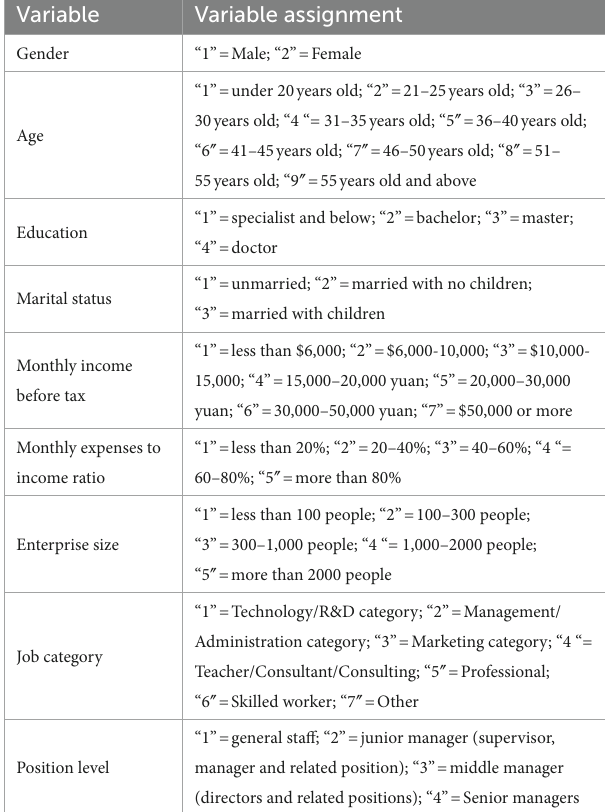
TABLE 1 Demographic variables and assigned